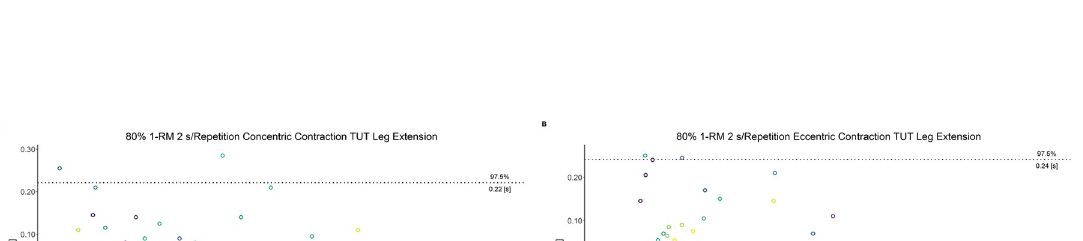
PLOS ONE | https://doi.org/10.1371/journal.pone.0254164 July 20,